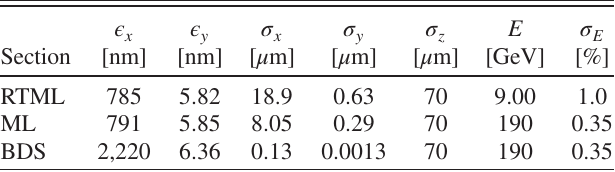
TABLE II. Simulated beam parameters at the end of each section for a perfect beamline. Projected emittances are given in this